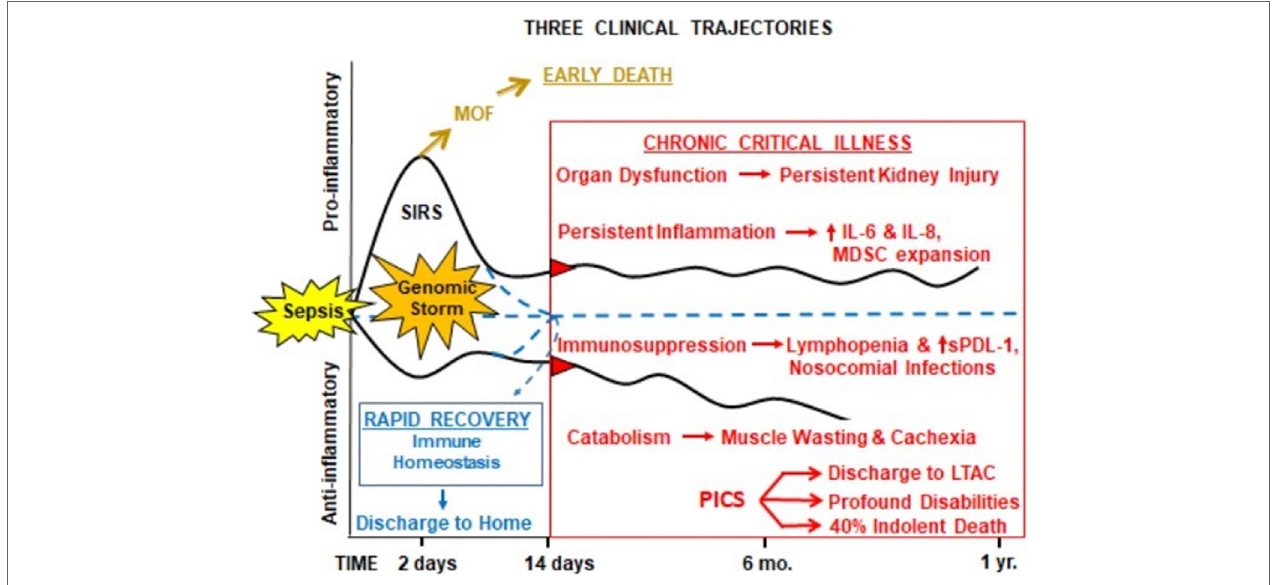
FigURe 1 | Proposed hypothesis for the PICS. Abbreviations: SIRS, systemic inflammatory response syndrome; MDSC, myeloid-derived suppressor cell; sPDL-1, soluble programmed death ligand-1; LTAC, long-term acute care facility; PICS, persistent inflammation, immunosuppression, and catabolism syndrome.